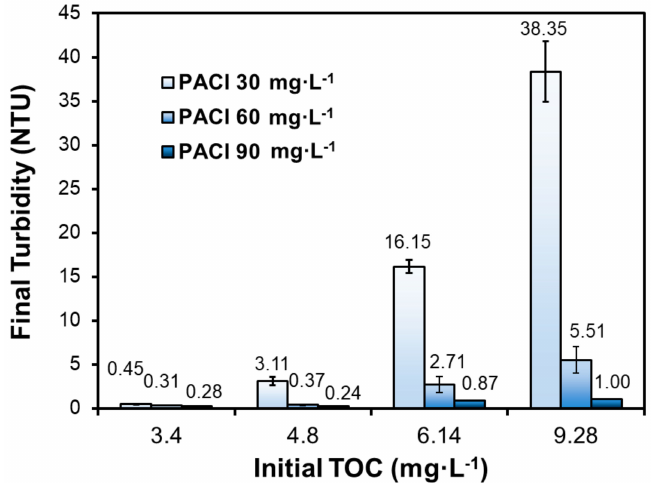
Figure 4. Final turbidity at four initial TOC levels with three PACl dosages at 7 ◦ C. (Initial pH = 7.47, initial turbidity = 70.00 NTU; data plotted as mean of duplicates and error bars calculated as standard deviation to indicate data